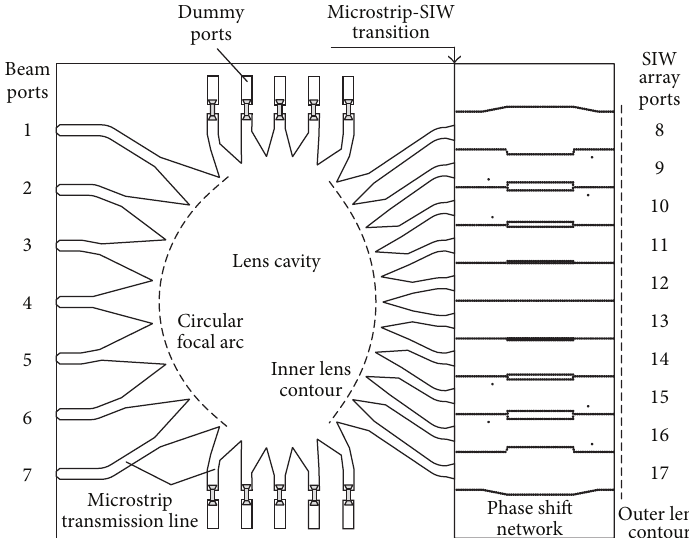
Figure 8: Geometry of the Rotman lens.